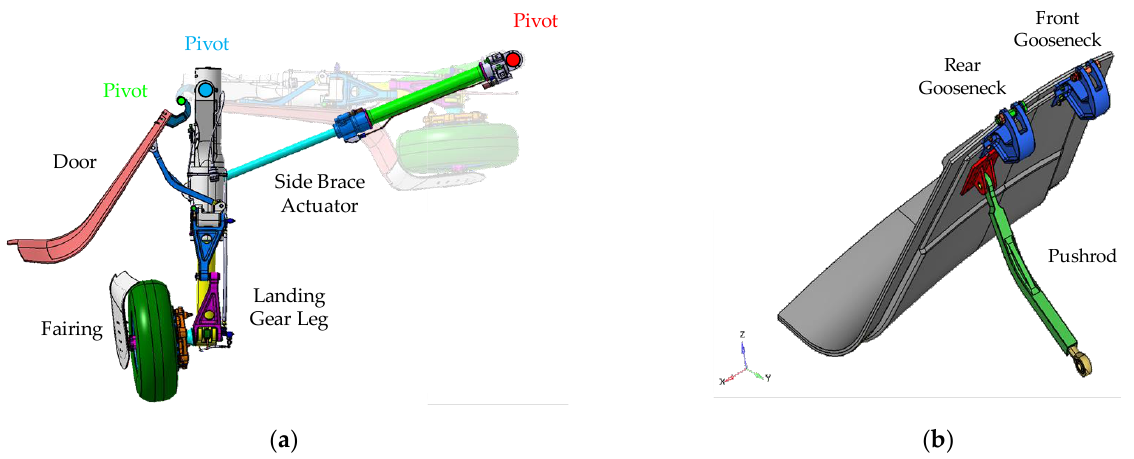
Figure 2. Main landing gear (MLG) system architecture: ( a ) door and fairing with the actuation system; ( b ) MLG door with a focus on the metallic gooseneck connecting the door to the airframe and the pushrod linking the door to the LG (Landing Gear) leg.